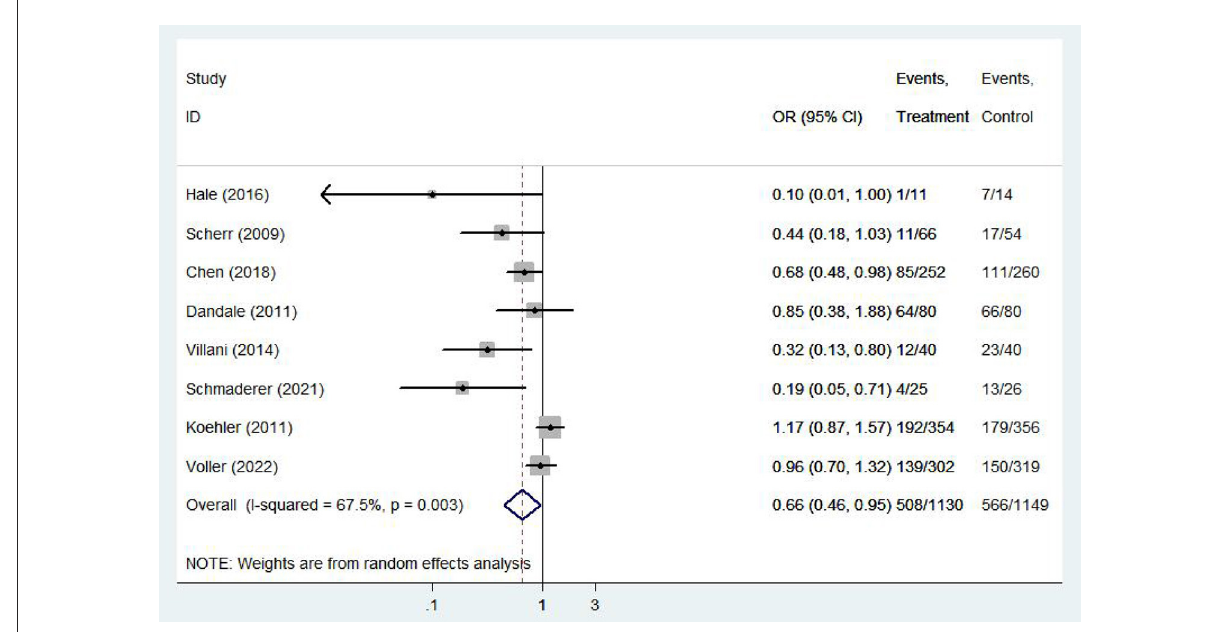
FIGURE6 Forest plots showing the effects of all-cause hospitalization rate.